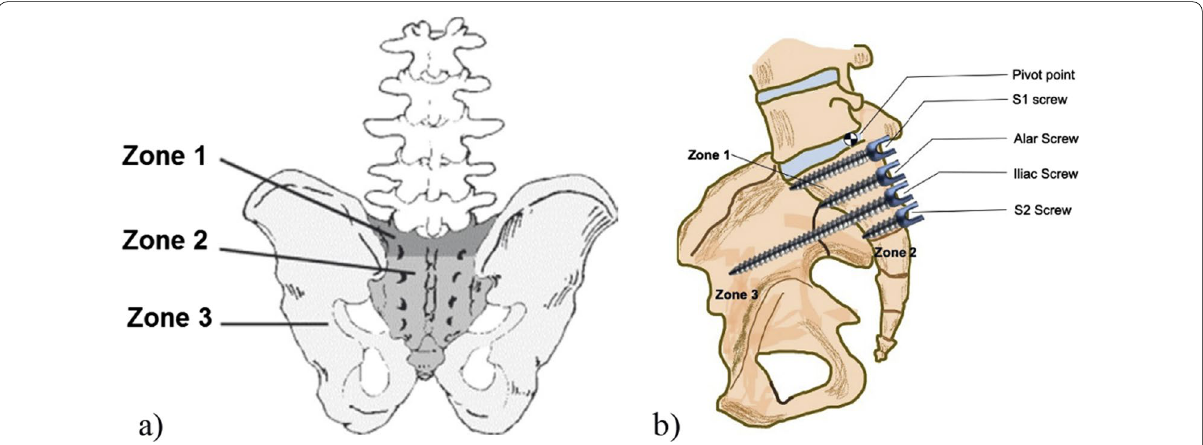
Fig. 4 a The sacropelvic zones of O’Brien [11]. b Sacropelvic fixation options in relation to McCord’s pivot point and zones of O’Brien